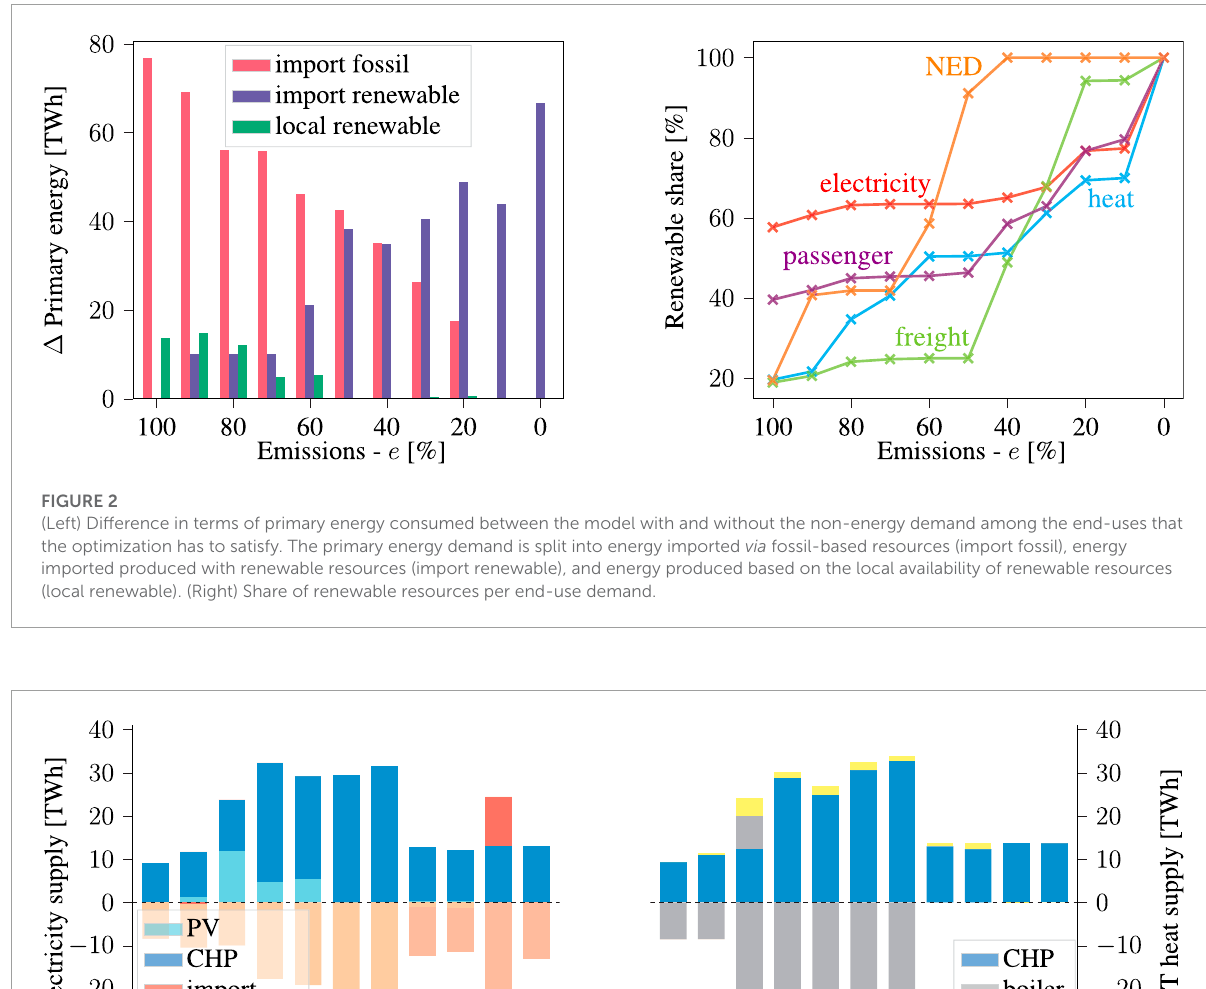
FIGURE 3 Impact of the non-energy demand on the technologies selected for the electricity supply (left) and the high-temperature (HT) heat supply (right). The y -axis represents the difference in energy supplied per technology. In the legend, “electr” refers to the electrical resistor.